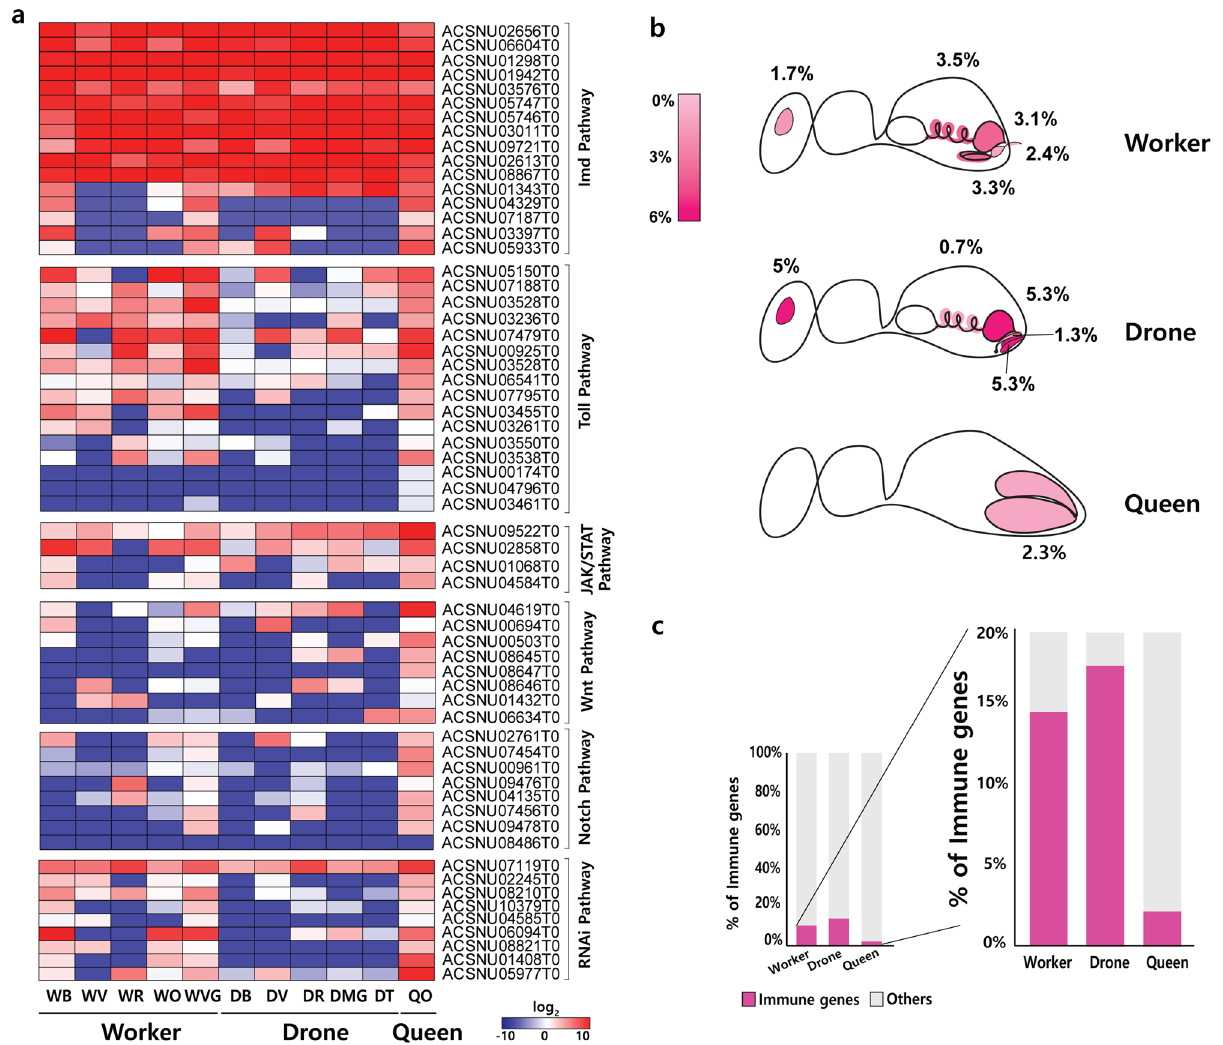
Figure 4. Differences in immune system transcripts across castes. ( a ) Heat map of individual immune genes. ( b ) Distribution of immune-related transcripts in the organs of each caste shown on a pink-scale. Expression ratio showing the proportion of immune-related transcripts expressed among organs in each caste. ( c ) Immune genes as a fraction of all transcripts across castes. The collected organs are shown. WB worker brain, WV worker ventriculus, WR worker rectum, WO worker ovary, WVG worker venom gland, DB drone brain, DV drone ventriculus (midgut), DR drone rectum, DMG drone mucus gland, DT drone testis, QO queen